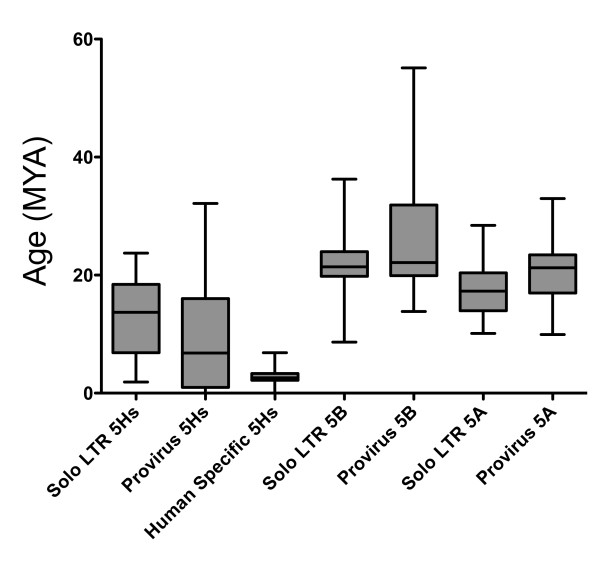
Age of HML-2 LTRs. LTRs from 5Hs, 5A, and 5B subgroups were used to determine distance measurements as a function of time of integration. Ages of "Solo LTR" elements were determined as described in Methods, while "Provirus" element ages were determined by 5' to 3' distance measurement. "Human Specific 5Hs" refers to solo LTRs that are only found in the human genome, and whose age was calculated using the solo LTR age calculation method.